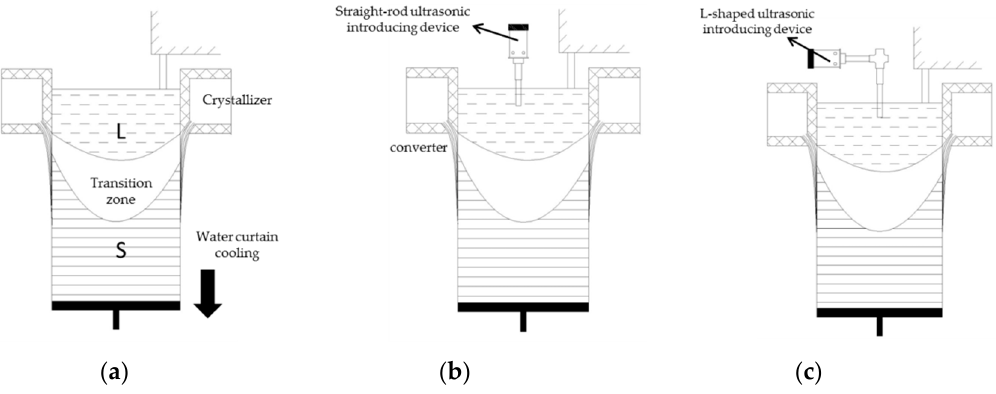
Figure 2. Different casting processes: ( a ) semi-continuous casting without ultrasonic treatment; ( b ) semi-continuous casting with the straight ultrasonic-introducing rod; ( c ) semi-continuous casting with L-shaped ultrasonic-introducing rod.